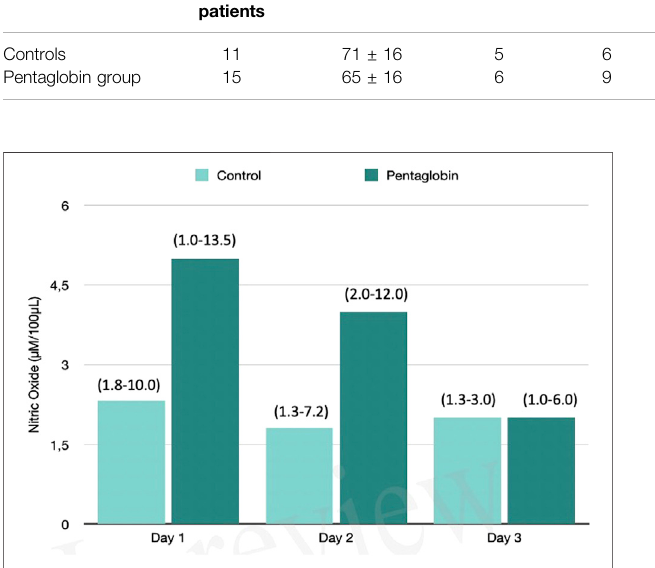
FIGURE 2 | Comparison of SOFA changes over time between Pentaglobin and control groups by linear mixed models ( p (cid:1) 0.49). The height of bars represents the median values and the numbers in brackets the corresponding interquartile range of SOFA scores calculated daily to assess the severity of critical illness and the development of organ failure in Pentaglobin treated patients during the fi rst 3 days of treatment after sepsis diagnosis compared with the control group. There was no signi fi cant difference in the SOFA score at admission between the Pentaglobin group and controls ( p (cid:1) 0.09). Furthermore, the use of Pentaglobin did not in fl uence the temporal evolution of SOFA ( p (cid:1) 0.49) versus the standard therapy. See text for more